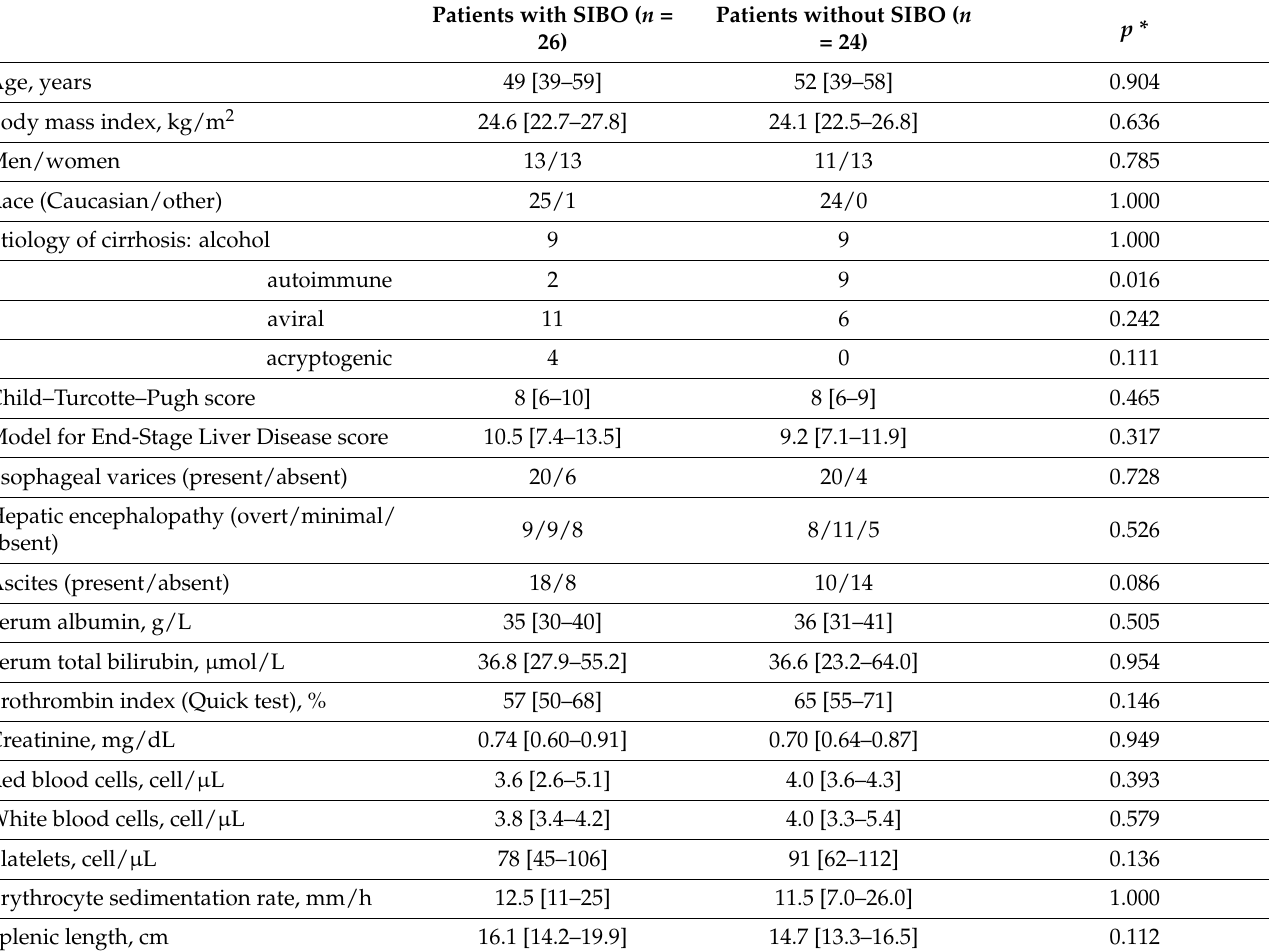
Table 1. Main characteristics of patients with small intestinal bacterial overgrowth (SIBO) and without it.